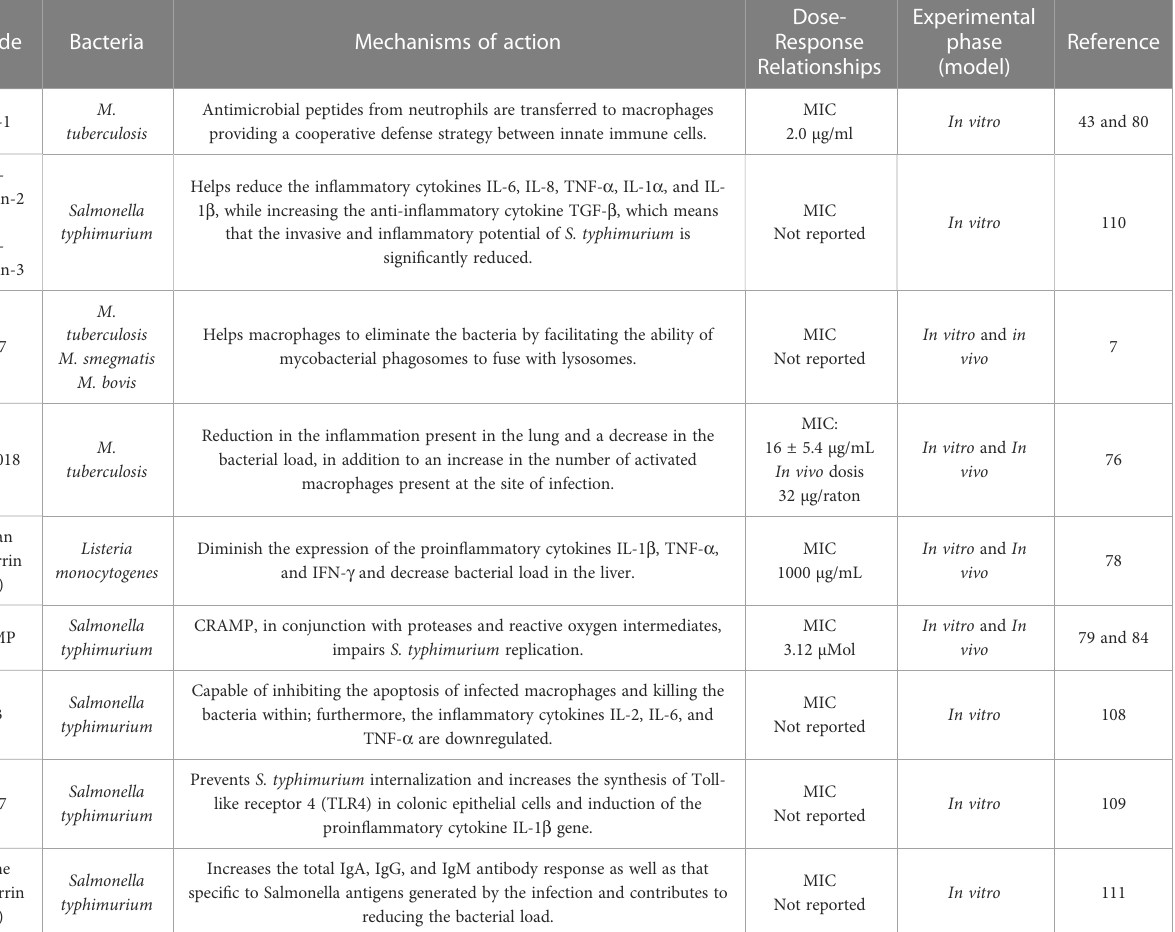
TABLE 3 Immunomodulation by AMPs in infections by intracellular bacteria.